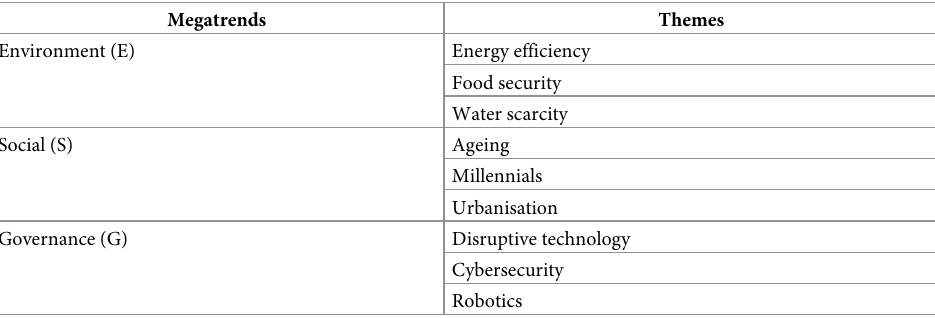
Table 1. Megatrends and